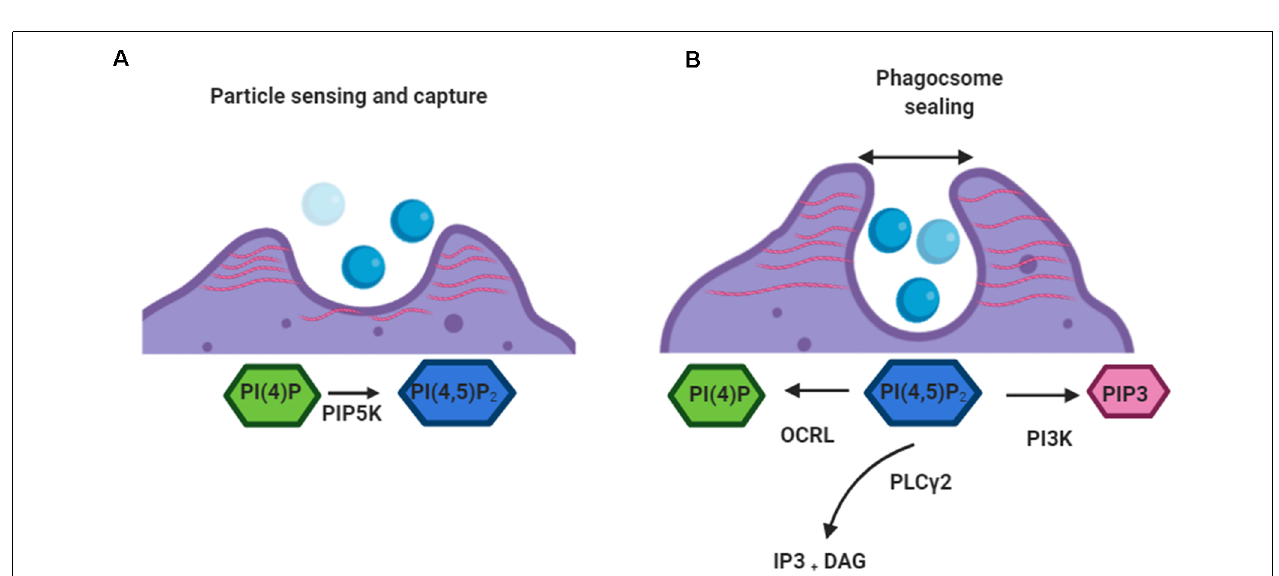
FIGURE 2 | Roles of PI(4,5)P 2 in early phagocytosis. (A) When a target is detected by a phagocytic cell PI(4)P is converted to PI(4,5)P 2 by PIP5K. PIP5K associates with the plasma membrane along its positively charged surface. PI(4,5)P 2 mediates linkage of actin networks (red) to integral plasmalemmal proteins through intermediary ezrin, radixin, and moesin (ERM) proteins. (B) When the phagosome sealing begins depletion of PI(4,5)P 2 from the base of the cup leads to the removal of actin filaments. PI(4,5)P 2 is converted by kinases (PI3K), phosphatases (OCRL), and phospholipases (PLC γ ). This allows the movement of the closed vacuole into the